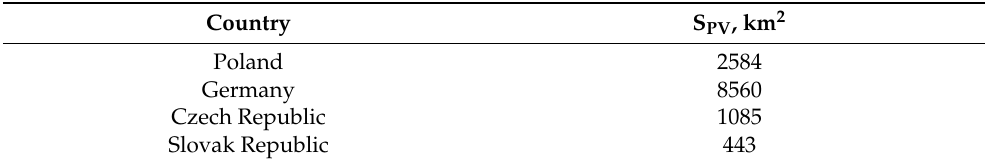
Table 1. Total surface areas of PV panels in hypothetical solar